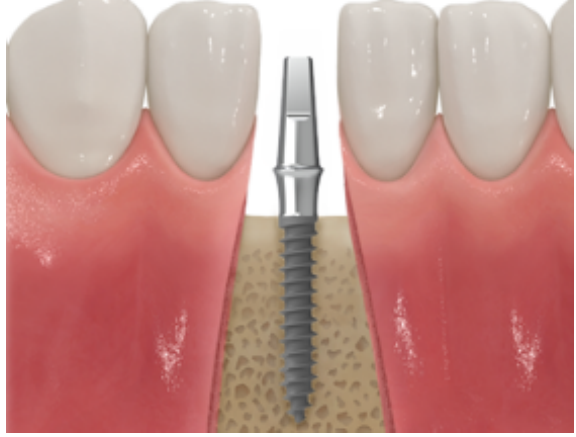
Figure 1. MACRO thread